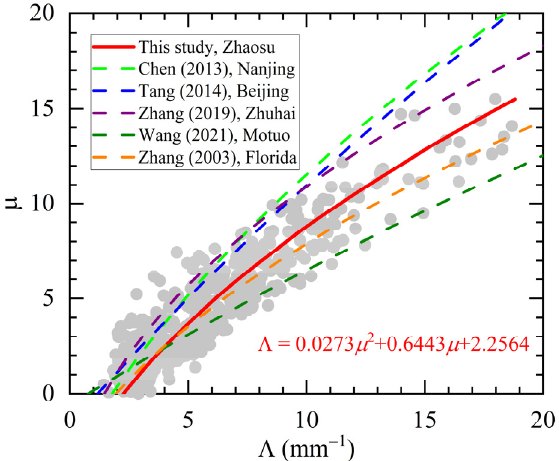
Figure 6. Scatterplots of μ versus ∧ , and the μ – ∧ relation represented by red line and equation for the rainfall in Zhaosu. The dashed lines represent the derived relations in Nanjing [29], Beijing [83], Zhuhai [79], Motuo [34], and Florida [63] with corresponding colors.